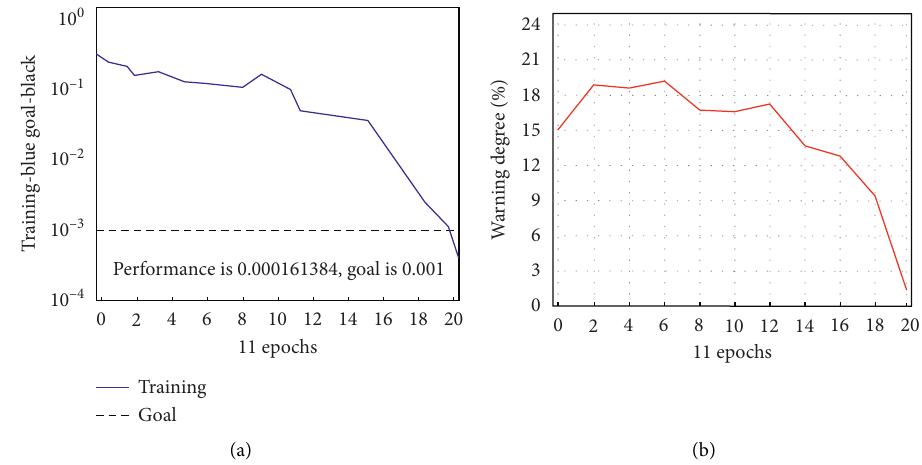
Figure 6: Training convergence (a) and training warning indicator (b) of the BP neutral